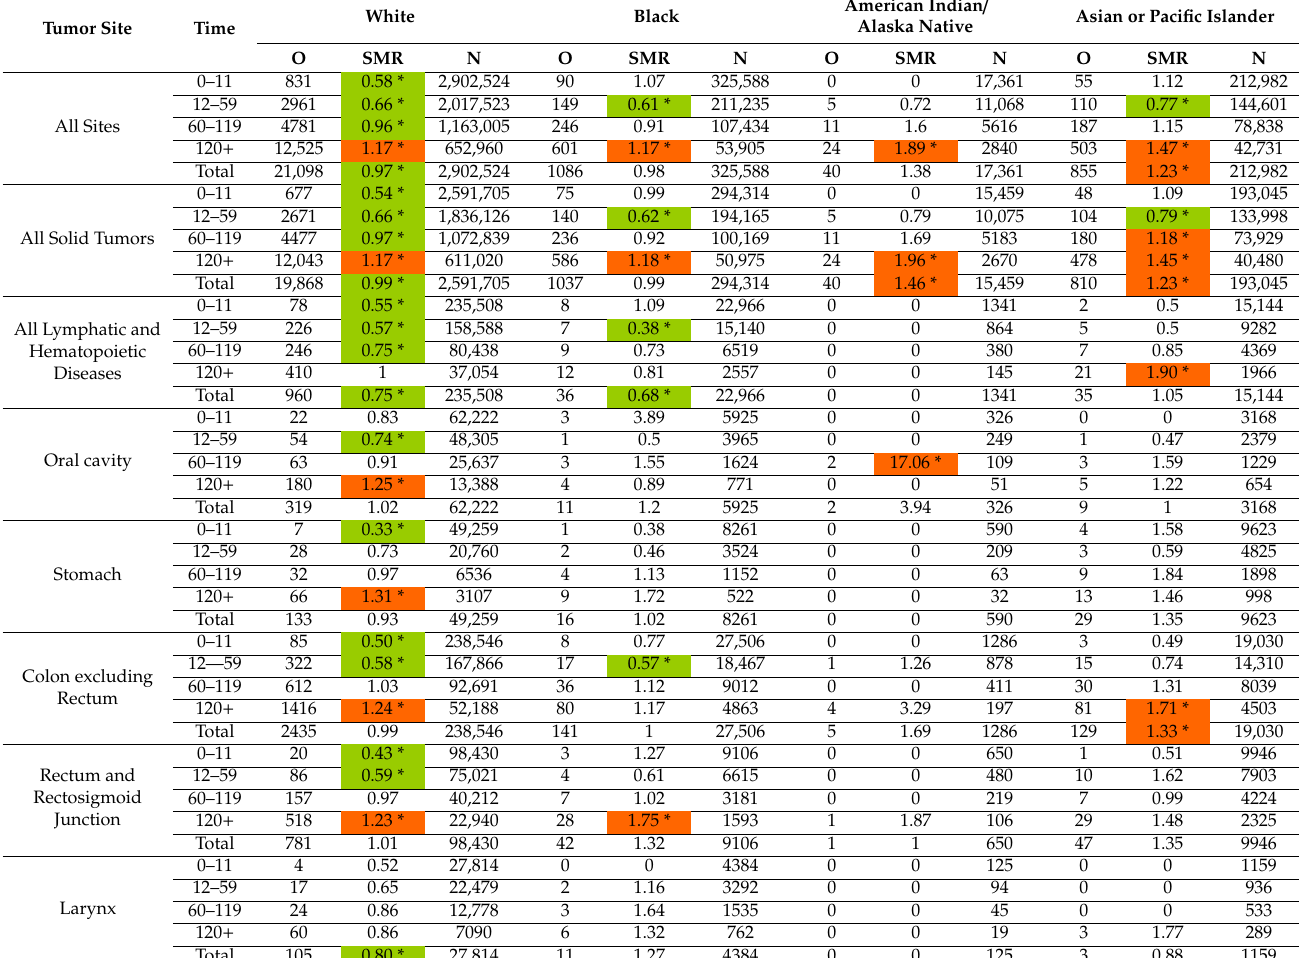
Table 2. Analysis of the risk of death due to Alzheimer’s disease (AD) in cancer patients relative to the general